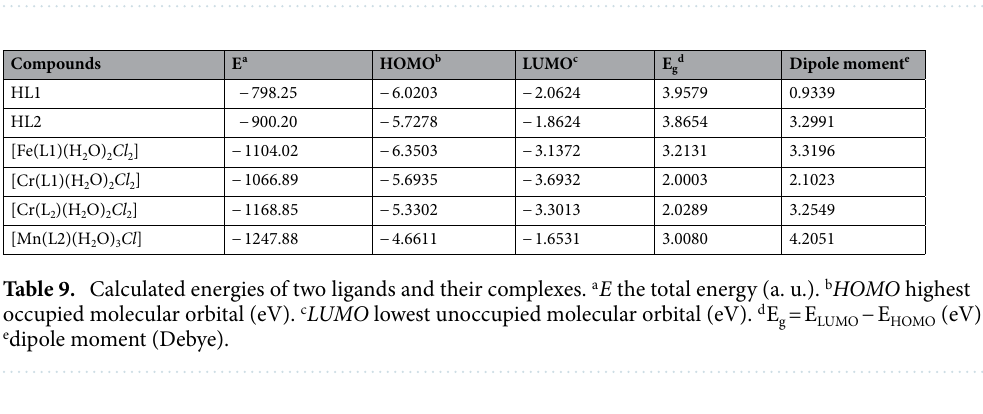
Figure 7. Molecular electrostatic potential (MEP) surface of ligands (HL1 and HL2) and their metal complexes.